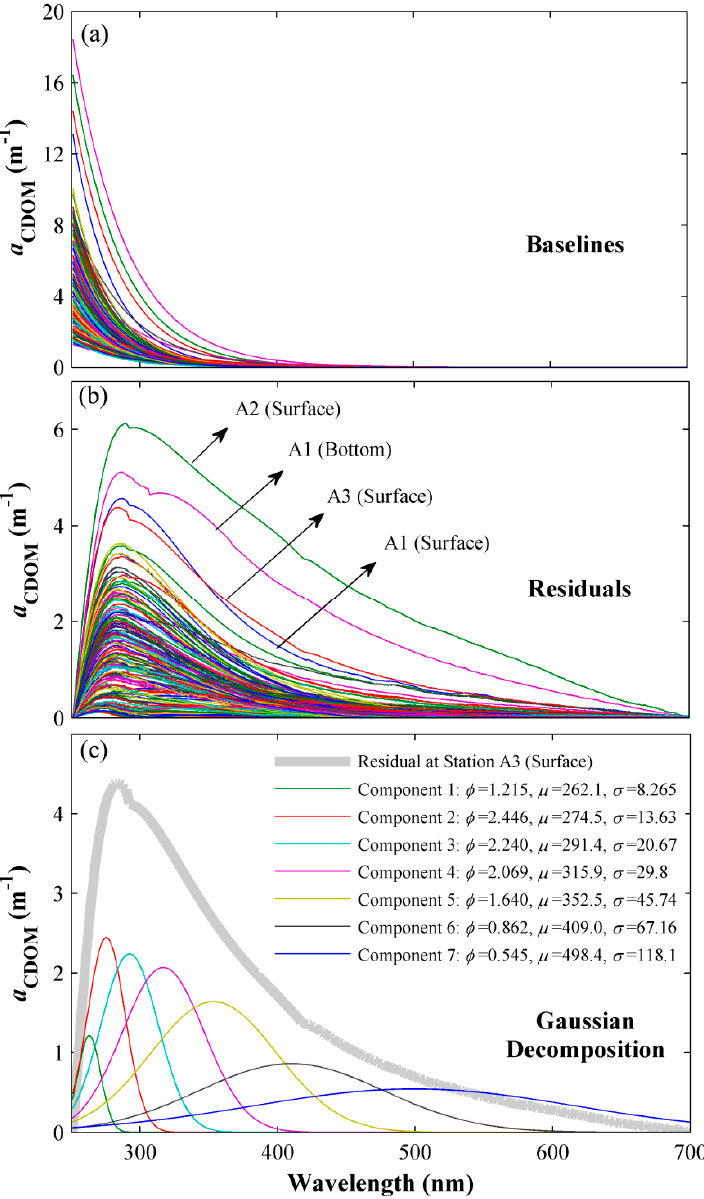
Figure 6. The ( a ) baselines, ( b ) residuals, and ( c ) Gaussian components separated from CDOM absorption spectra collected in the Pearl River Estuary at the surface and bottom. The gray line in ( c ) is the residual curve of a surface sample (Station A3); the colored lines are the seven decomposed Gaussian components. The peak height ( ϕ ), peak position ( µ ), and curve width ( σ ) of the components are listed in the legend.